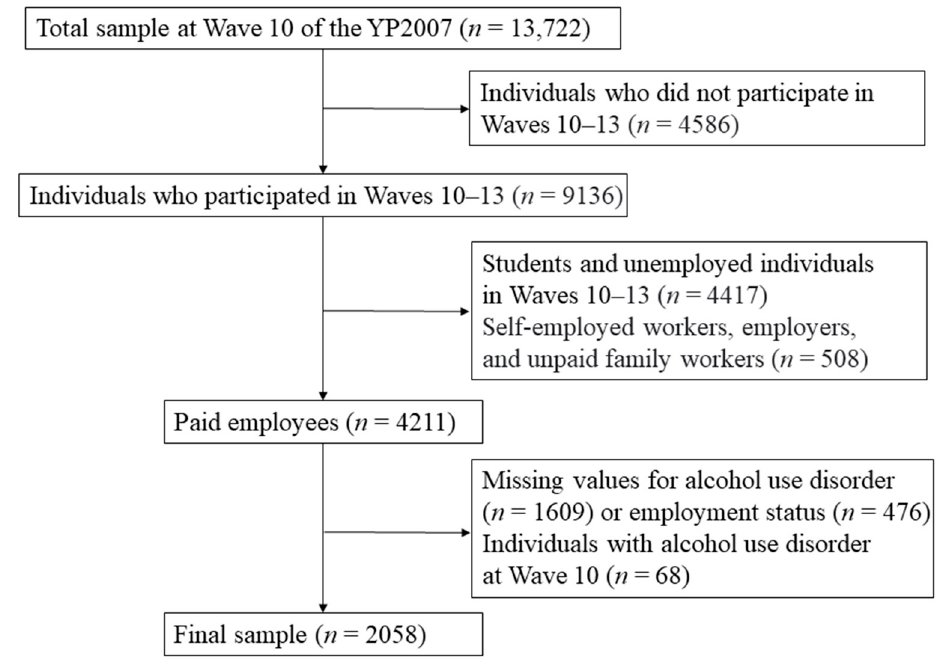
Figure 1. The study population using Waves 10–13 of the YP2007 survey.